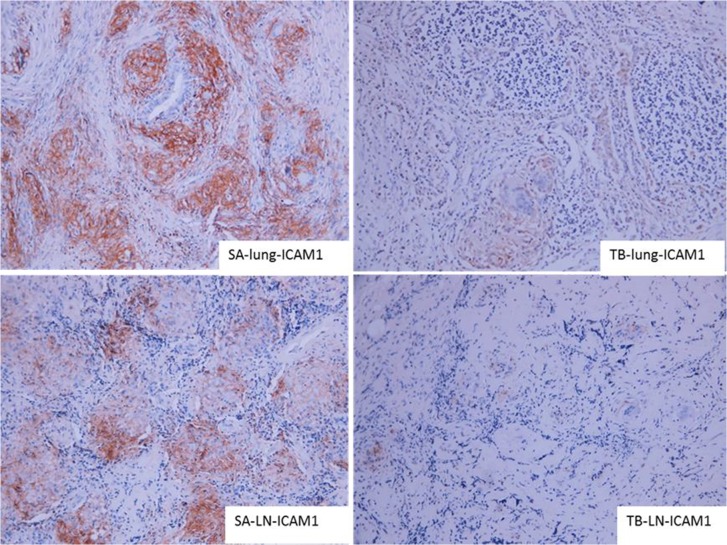
IHC analysis of lung sections from patients in the SA and TB groups.Staining for ICAM-1 is shown (×200). ICAM-1 showed scattered, clustered, strong expression in the lungs and lymph nodes of patients in the SA group but exhibited nonspecific staining or weak expression in the lungs of patients in the TB group. Additionally, a hazel-colored region was observed in the tissues adjacent to the granuloma (Fig 3).